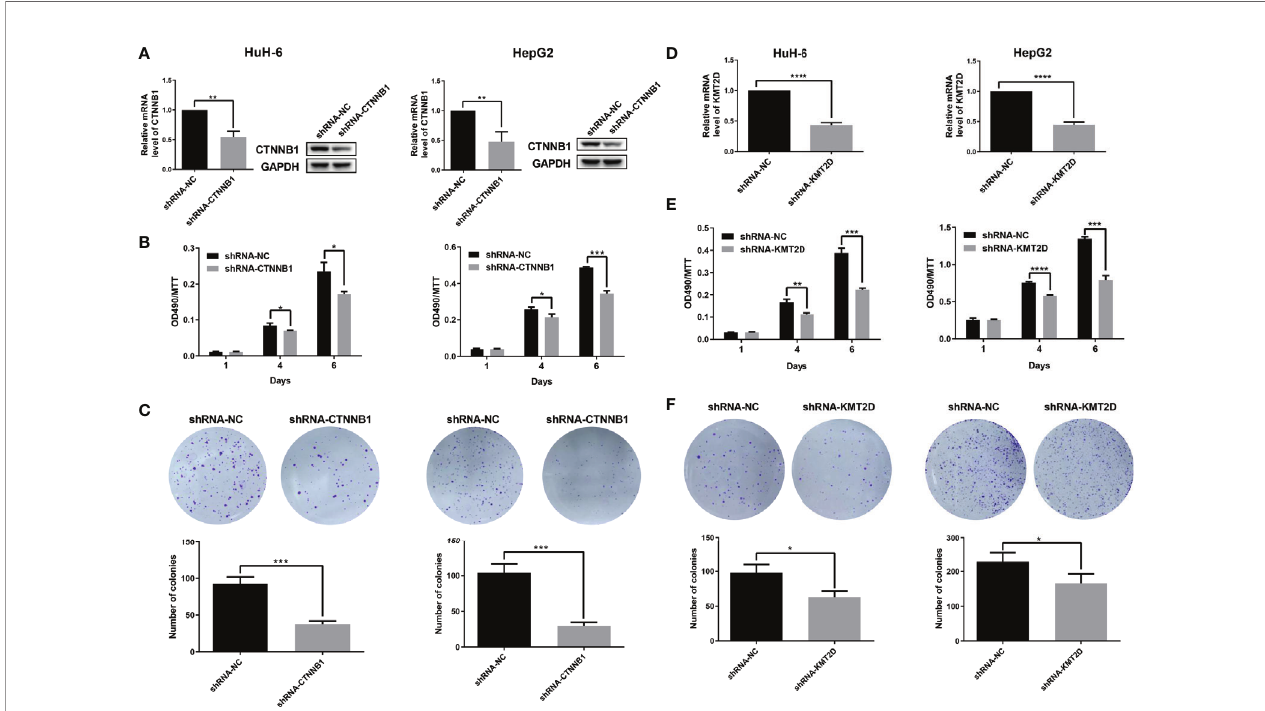
FIGURE 7 | Preliminary functional screening of candidate cancer-associated genes in HB. (A) The mRNA and protein levels of CTNNB1 after lentivirus-mediated knockdown were assessed using qRT-PCR and western blotting in HUH-6 and HepG2 cells. (B) Cell proliferation was detected by MTT assays at the indicated days in HUH-6 and HepG2 cells after lentivirus-mediated knockdown of CTNNB1 . (C) Colony formation assay showing the effects of the CTNNB1 gene knockdown on the proliferation of HUH-6 and HepG2 cells. Experiments were repeated at least three times, each bar shows the mean ± SD (* P < 0.05, ** P < 0.01, *** P < 0.001, **** P < 0.0001). (D) The mRNA levels of KMT2D after lentivirus-mediated knockdown were assessed using qRT-PCR in HUH-6 and HepG2 cells. (E) Cell proliferation was detected by MTT assays at the indicated days in HUH-6 and HepG2 cells after lentivirus-mediated knockdown of KMT2D . (F) Colony formation assay showing the effects of the KMT2D gene knockdown on the proliferation of HUH-6 and HepG2 cells. Experiments were repeated at least three times, each bar shows the mean ± SD (* P < 0.05, ** P < 0.01, *** P < 0.001, **** P <